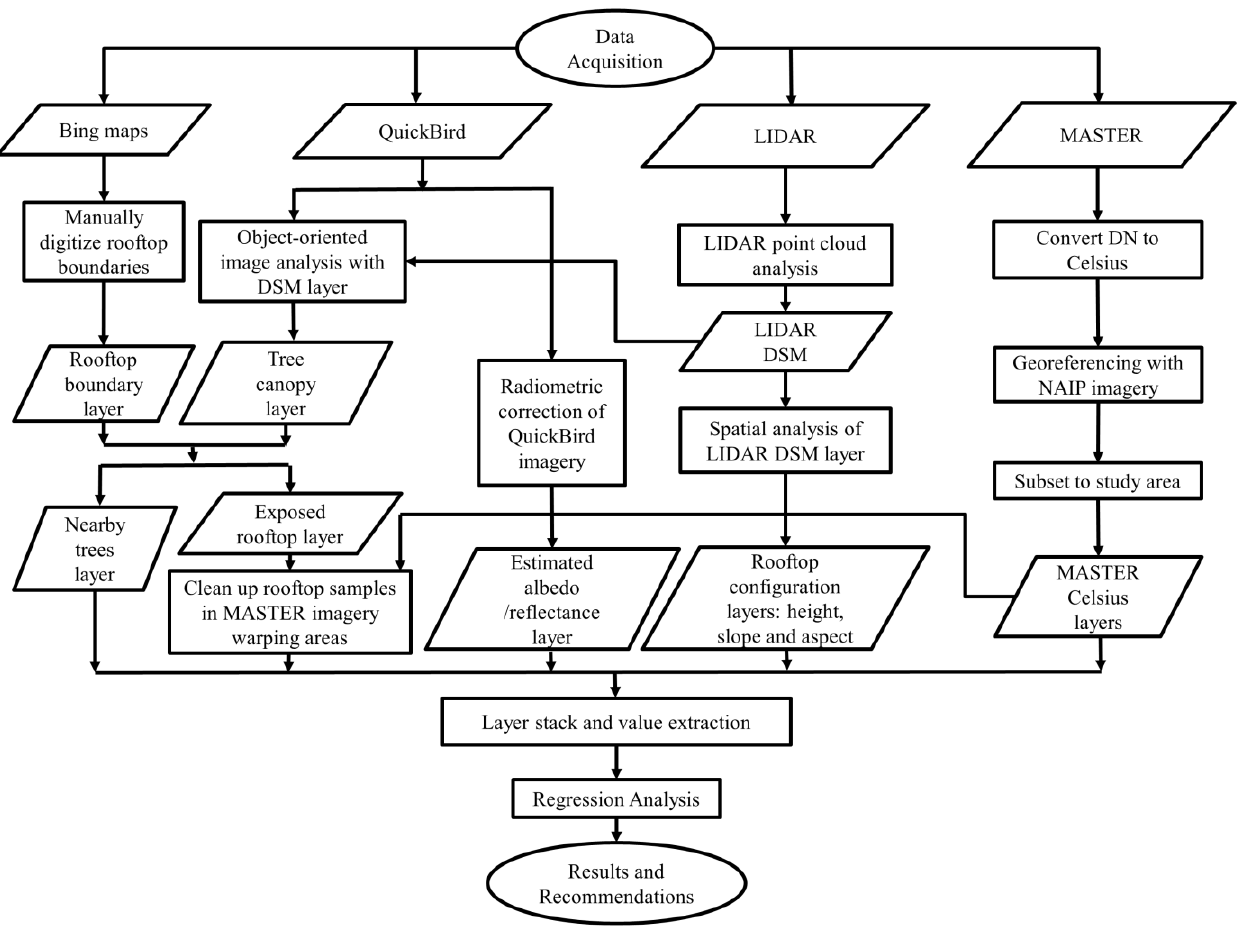
Figure 6. Methodology framework (QuickBird image classification, LIDAR point clouds analysis and atmospheric and geometric correction of MASTER